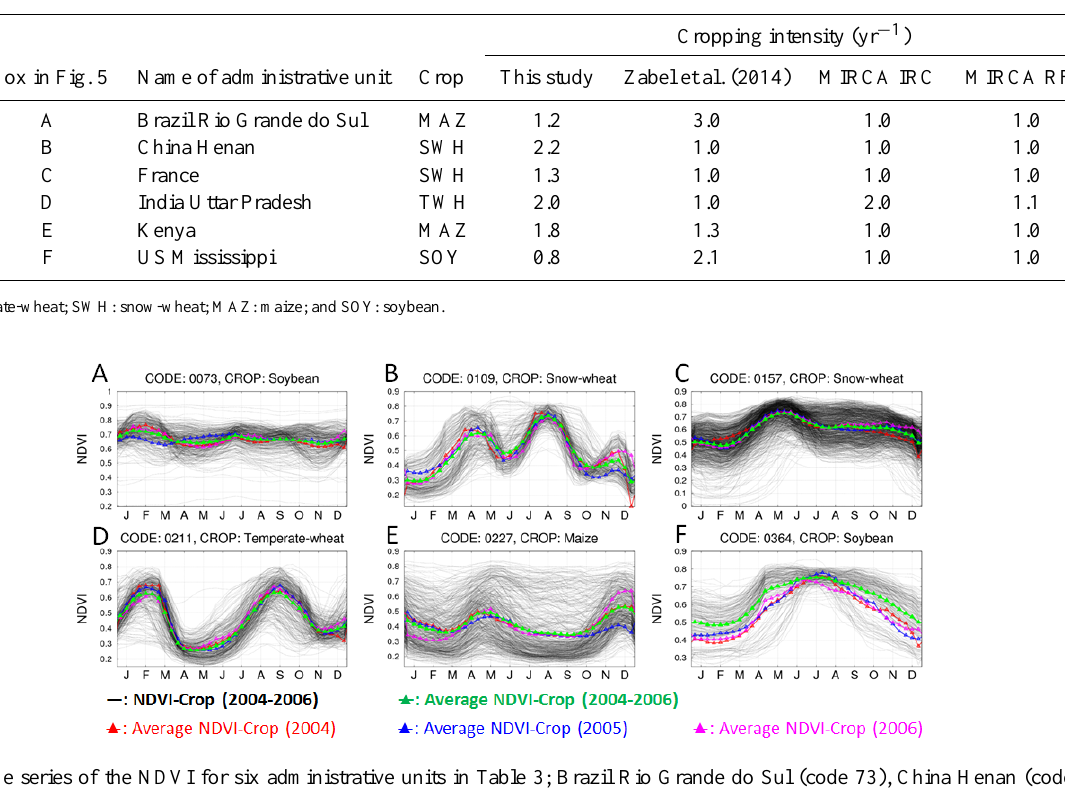
Table 3. Comparison of estimated cropping intensity in this study, Zabel et al. (2014), and MIRCA2000 simplified cropping intensity for irrigated (IRC) and rain-fed (RFC) crop classes in six administrative units (six boxes A–F in Fig. 5a and b). Averaged cropping intensities over the administrative units are shown as “Cropping intensity”. “Code” and “Crop” represent the assigned code of the administrative unit in SACRA and the dominant crop in the major cultivation season in this study. The simplified cropping intensities are annual harvested area divided by maximum monthly cropped area, which are defined for both irrigated and rain-fed classes of 26 crop types.